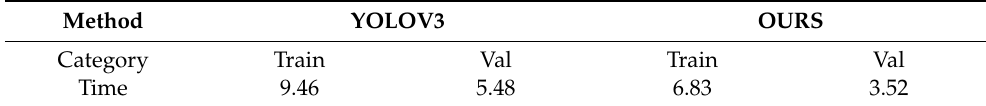
Table 5. Computational cost (SECOND).